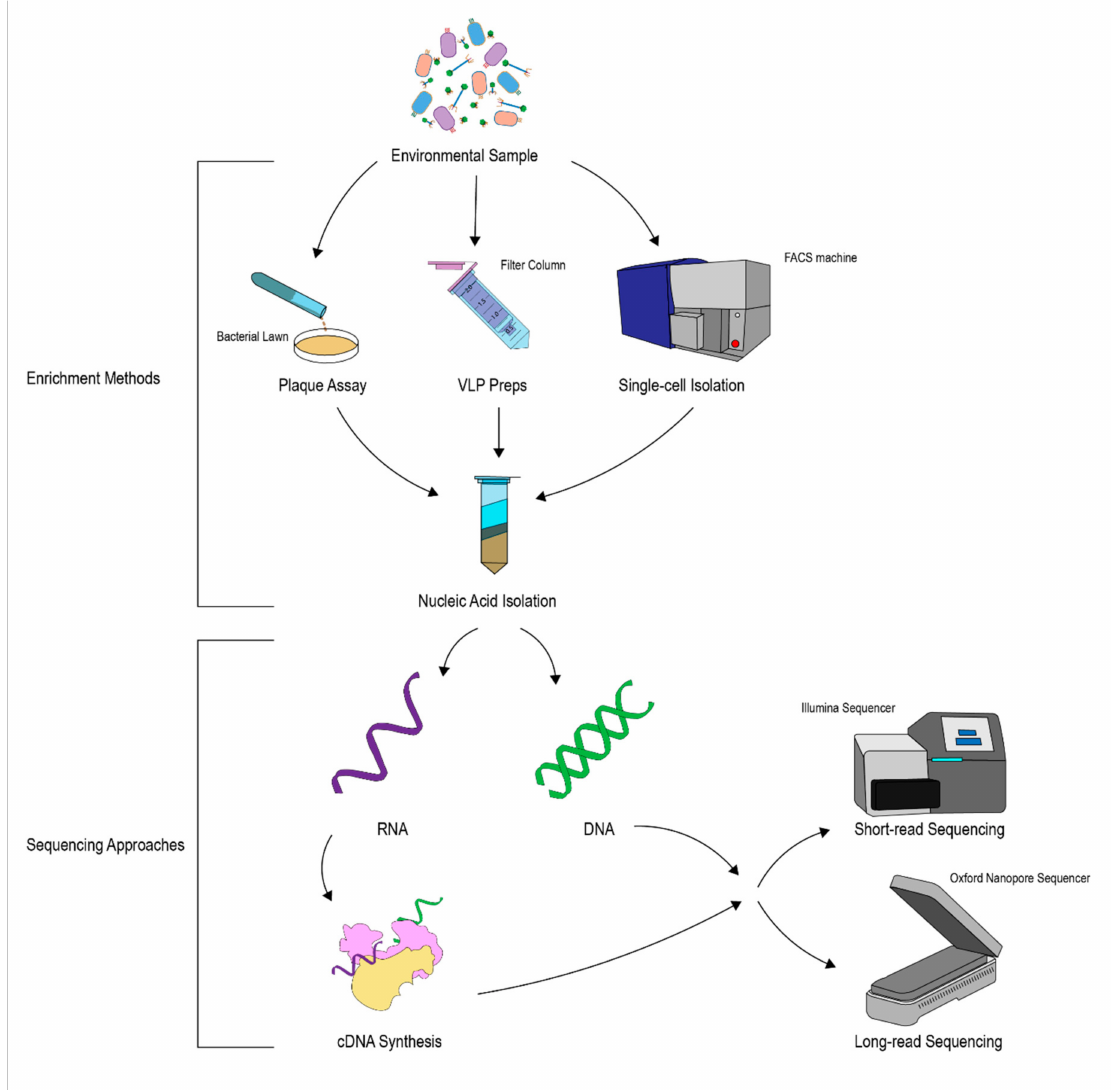
Figure 2. A flowchart describing potential methods for analyzing phages from an environmental sample containing a complex mixture of microbes and viruses. Methods for enriching phages from these samples include plaque assays, virus-like particle preparations, and single-cell isolation. Nucleic acid can then be purified from the enriched samples. The nucleic acid can then be sequenced either by short-read sequencing or long-read sequencing, though generally, a combination of both can produce the best genome assemblies